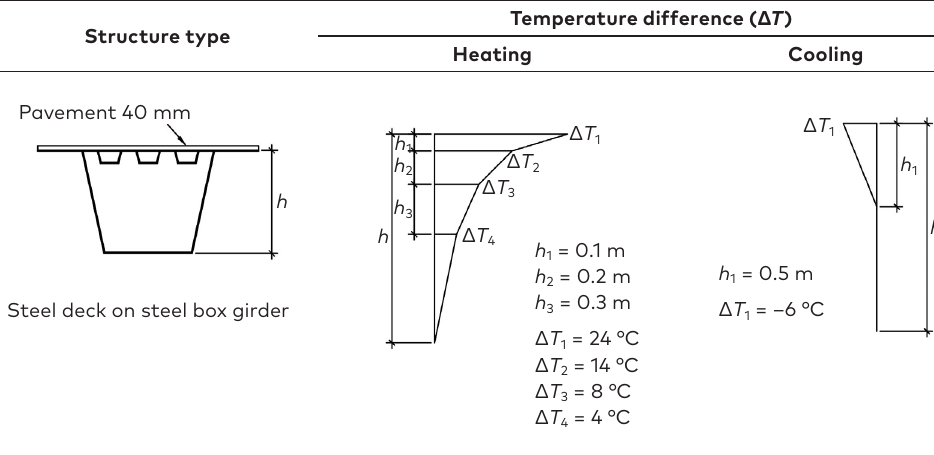
Figure 1. Recommended profile of temperature difference in a steel girder in vertical direction acc. to Eurocode 1 (2005) (refers to situation when the bridge pavement is 40 mm